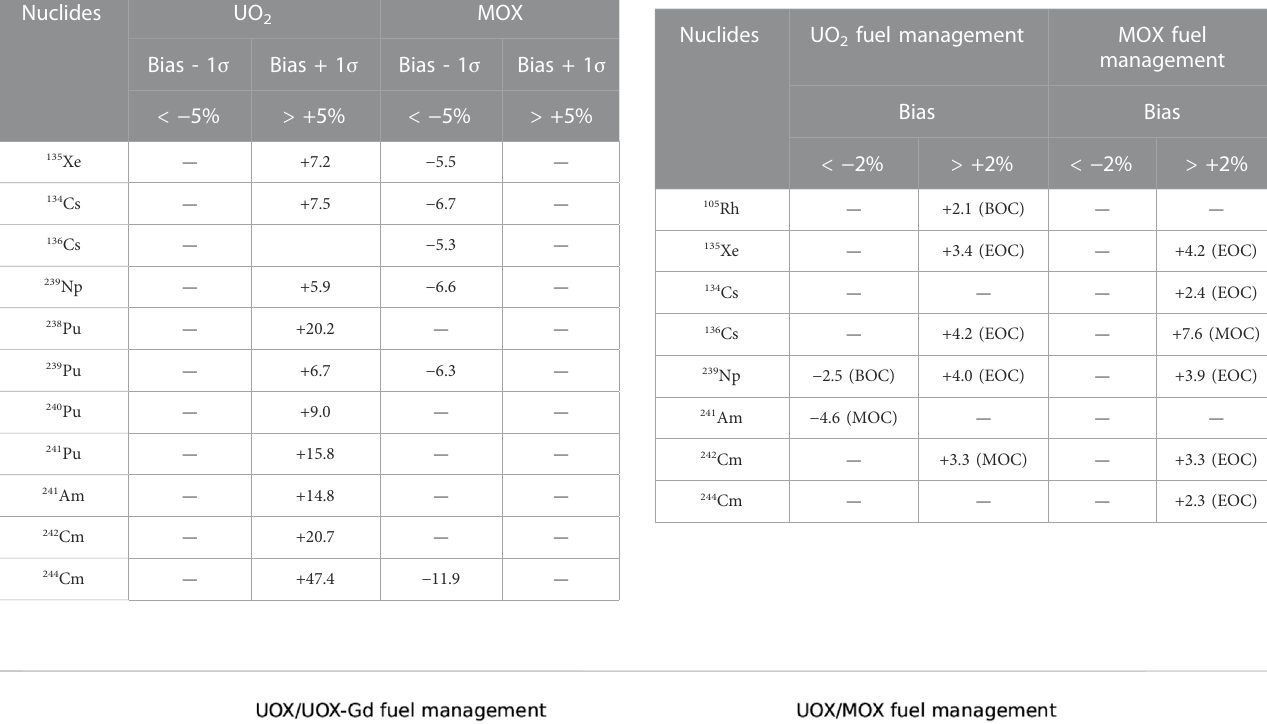
TABLE 6 Signi fi cant maximum discrepancies (bias ± 1 σ ) due to ILA.